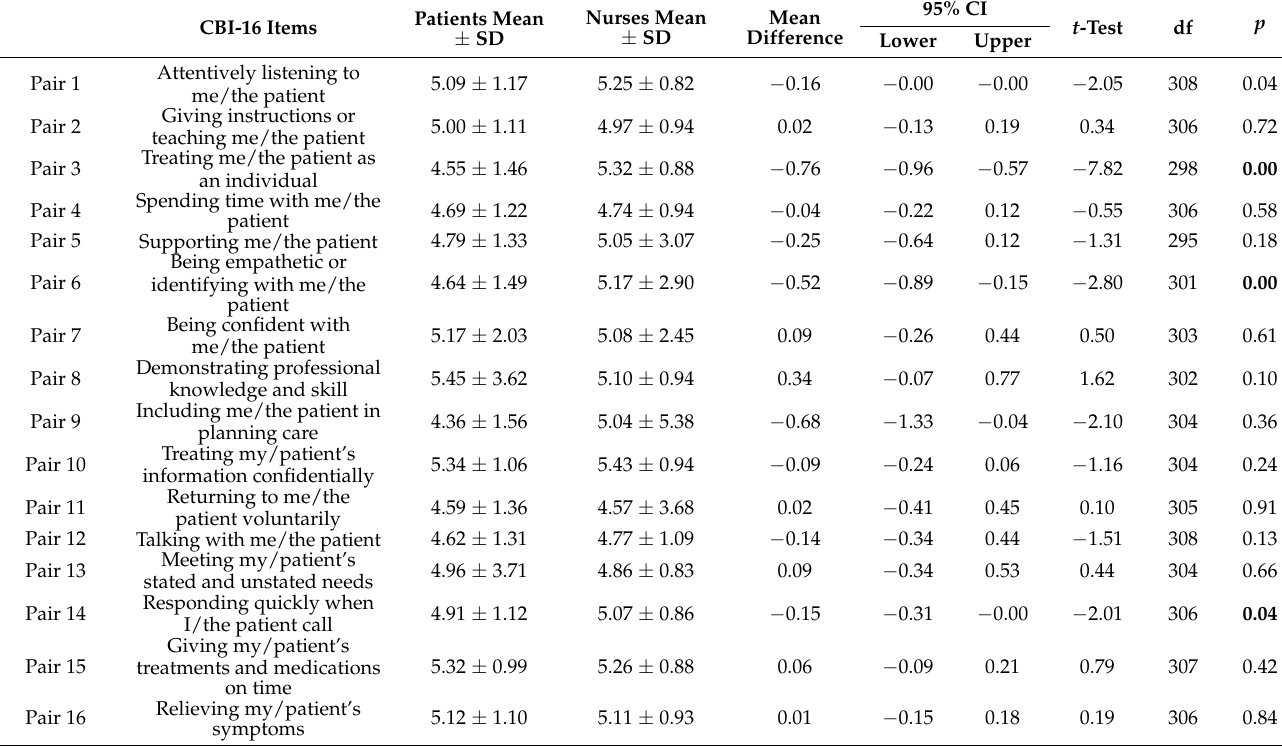
Table 4. Differences in the mean values of patients and